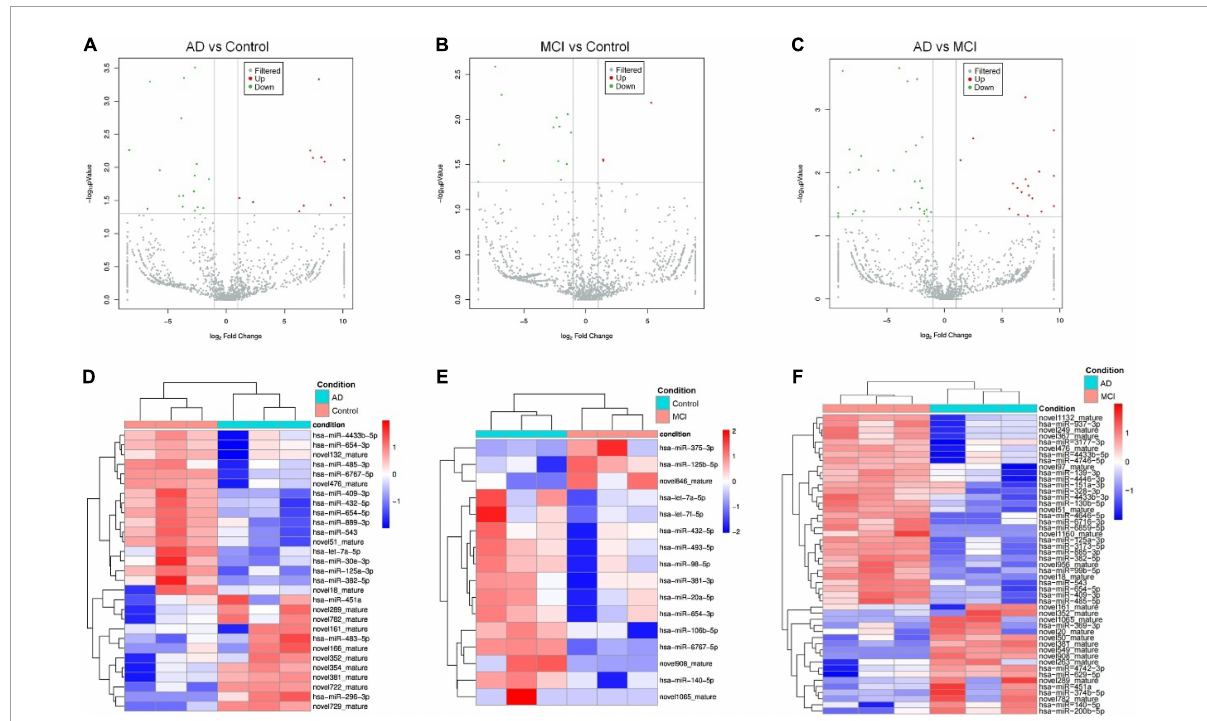
FIGURE1 Circulating exosomal miRNA expression profiles at different progression stages of AD. (A–C) The volcano plots of CEmiRs in AD vs. Control comparison (A) , MCI vs. Control comparison (B) , and AD vs. MCI comparison (C) . Dots in the volcano plot represent DECEmiRs. Values on X-axis refer to relative fold (log 2 ) between the expression levels of a given miRNA in EVs. Values on Y-axis refer to p -value (log 10 ) in each comparison. (D–F) Heatmap representation of the mean fold change of DECEmiRs in AD vs. Control comparison (D) , MCI vs. Control comparison (E) , and AD vs. MCI comparison (F) . Rows stand for DECEmiRs. Each entry of the grid refers to relative fold (log 2 ) between the expression level of a given miRNA in EVs. The color of each entry is determined by the value of that fold difference, ranging from blue (negative values) to red (positive